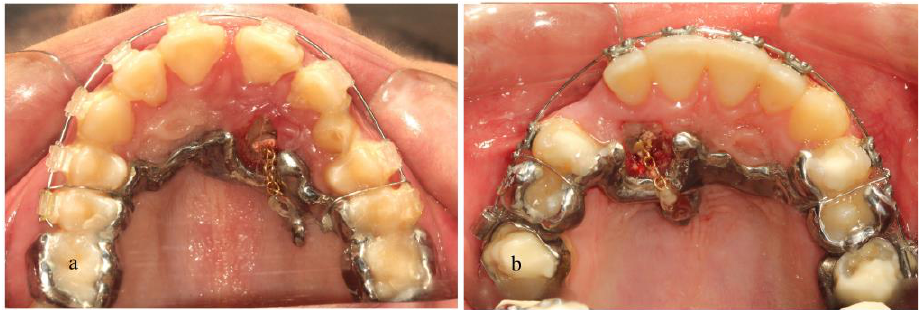
Figure 6. The gold chain apparatus mounted to the projection of the device, through an elastic chain (( a ): patient 1, ( b ): patient (( a ): patient 1, ( b ): patient 2).